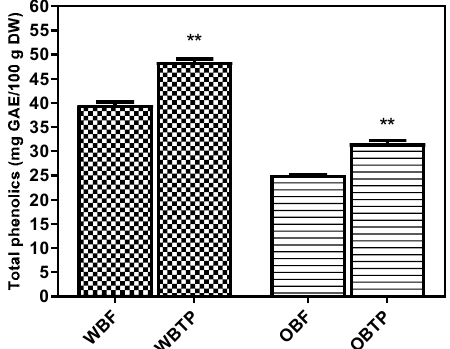
Figure 1. Total phenolic content (Folin–Ciocalteu method) of the wheat and oat bran extracts (fresh and thermally processed). The total phenolic content of the extracts is expressed as gallic acid equivalents (GAE) in mg/100 g dry weight (DW). Values are expressed as mean values ± standard deviation (SD), n = 3, and are followed by symbols (**) indicating significant differences ( p < 0.05) between samples (Student’s t -test; GraphPad Prism Version 8.0.1, Graph Pad Software, Inc., San Diego, CA, United States).